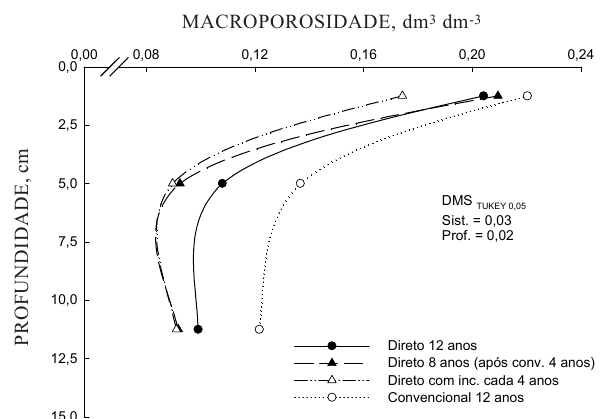
Figura 3. Macroporosidade do solo em diferentes sistemas de manejo e profundidades.